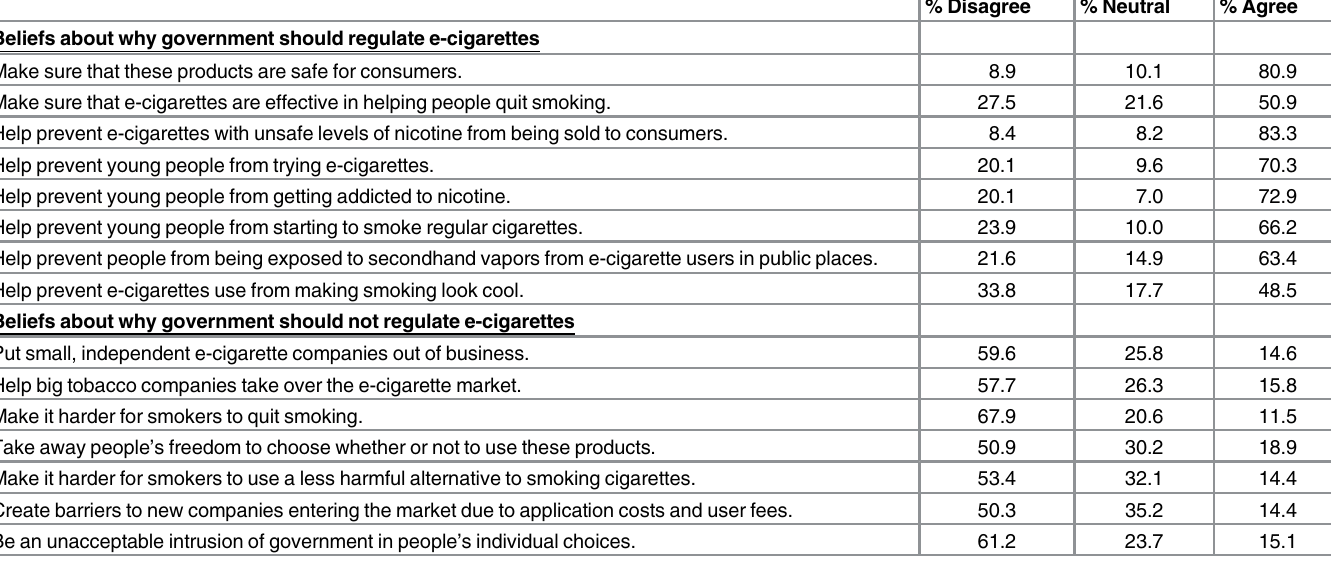
Table 2. Distribution of beliefs about why government should or should not regulate